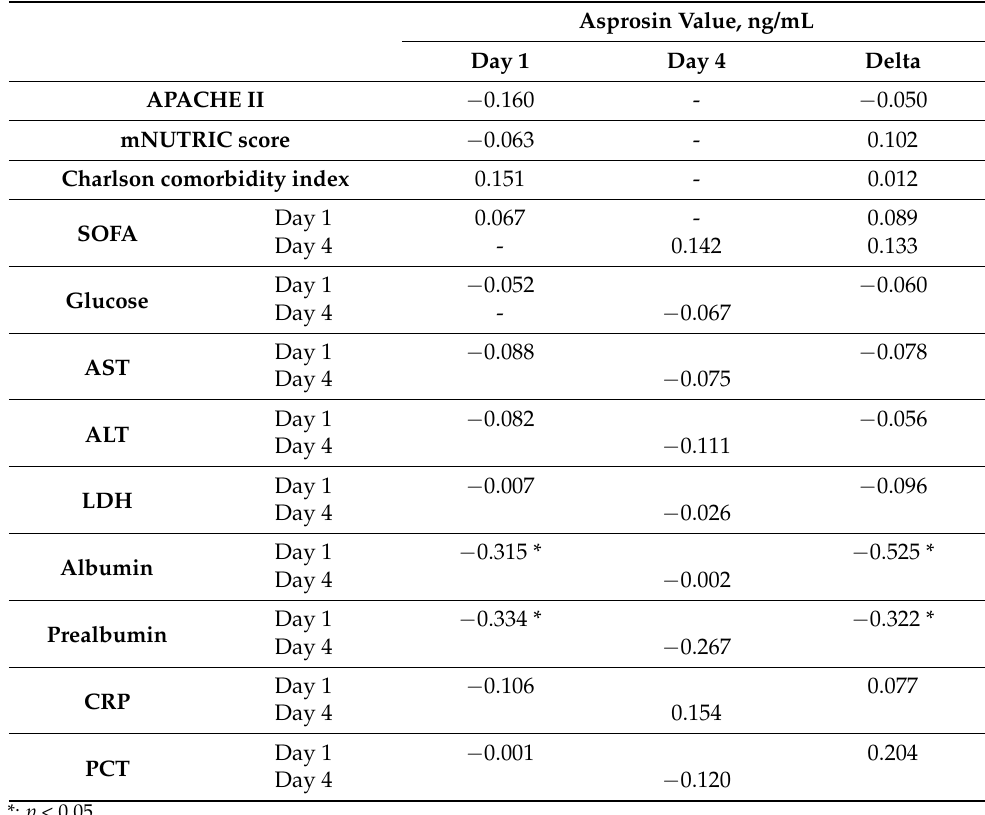
Figure 4. The Spearman correlation between the serum asprosin level and the received % of the daily energy target. Table 4. The Spearman correlation analysis between serum asprosin levels and severity of illness scores and some biochemical